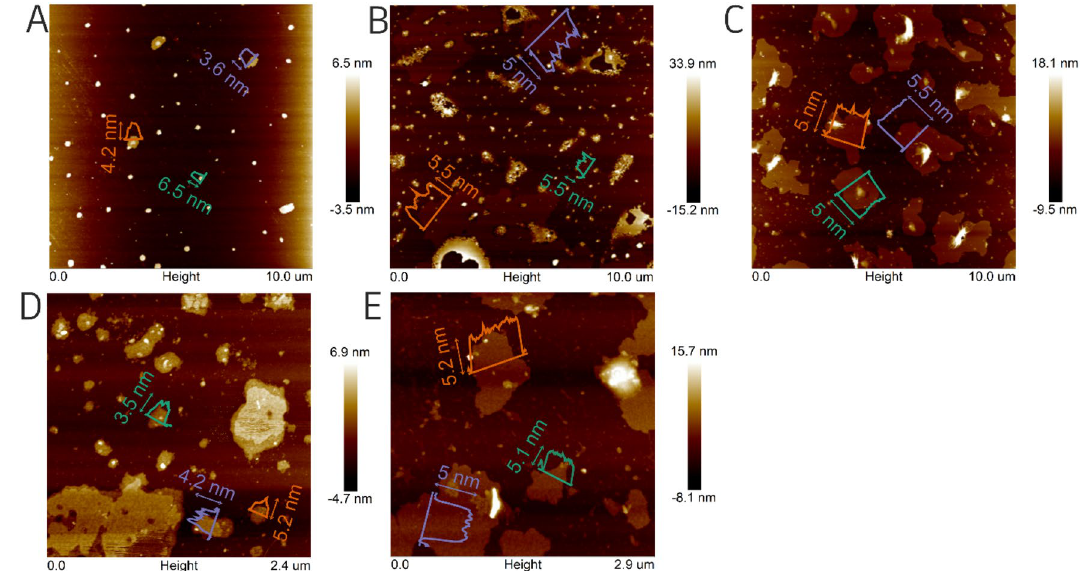
Figure 4. AFM images of boron after electrochemical exfoliation. ( A ) Cu_Li + _1 A, ( B ) Cu_Li + _0.5 A, ( C ) Cu_Li + _0.1 A, ( D ) Ni_Li + _1 A, ( E ) Ni_Li + _0.5